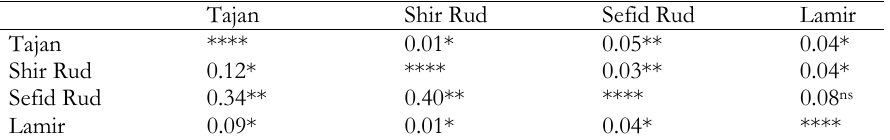
T ABLE 4. Analysis of genetic differentiation between pairs of populations across all loci based on values above and R values (above the diagonal) and R estimates of F st st